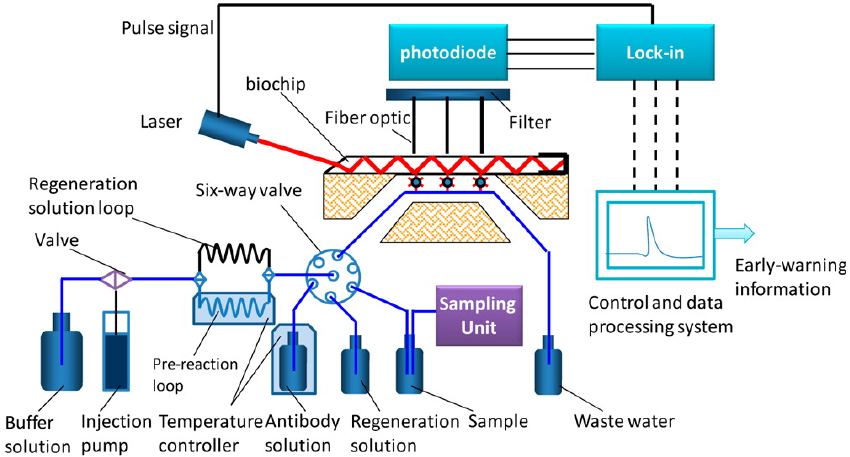
Figure 2. Modified scheme of the Automated Online Optical Biosensing System (AOBS) of Shi et al. , reprinted with permission from [135]. Copyright 2013 American Chemical Society.